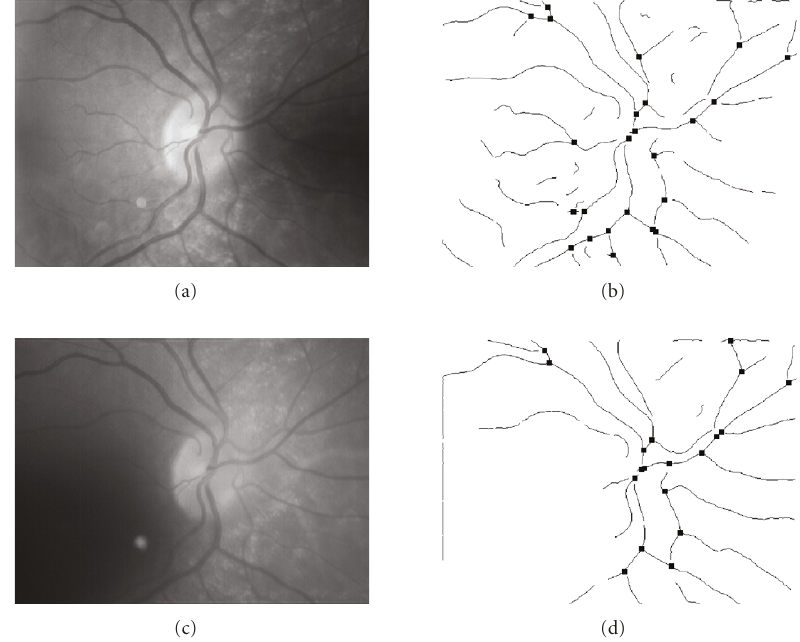
Figure 9: Examples of feature points obtained from images of the same individual acquired in di ff erent times. (a) (c) Original images. (b) Feature points image from (a). A total of 24 points are obtained. (d) Feature points image from (c). A total of 19 points are